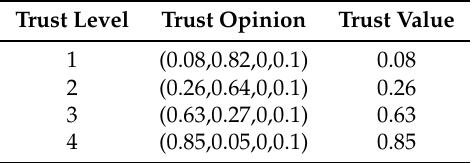
Table 5. Statistics of data-sets into real number values using four trust